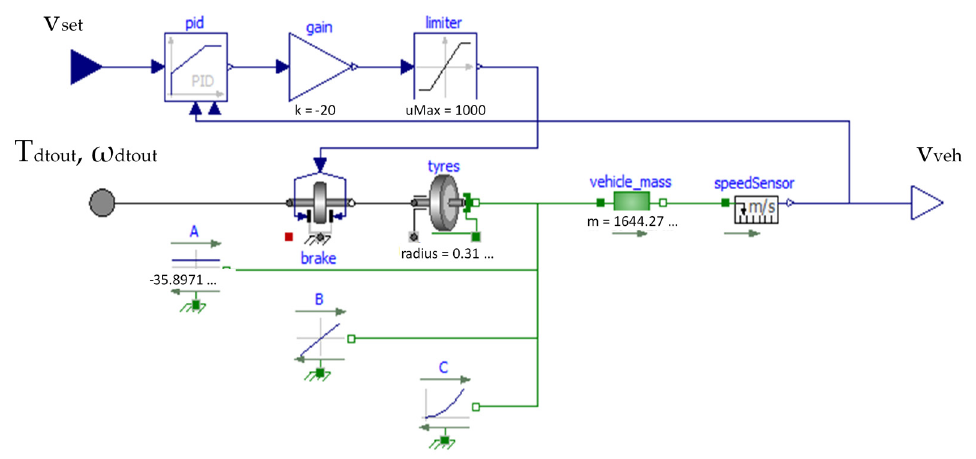
Figure 8. Diagram of the “vehicle” module in the developed test